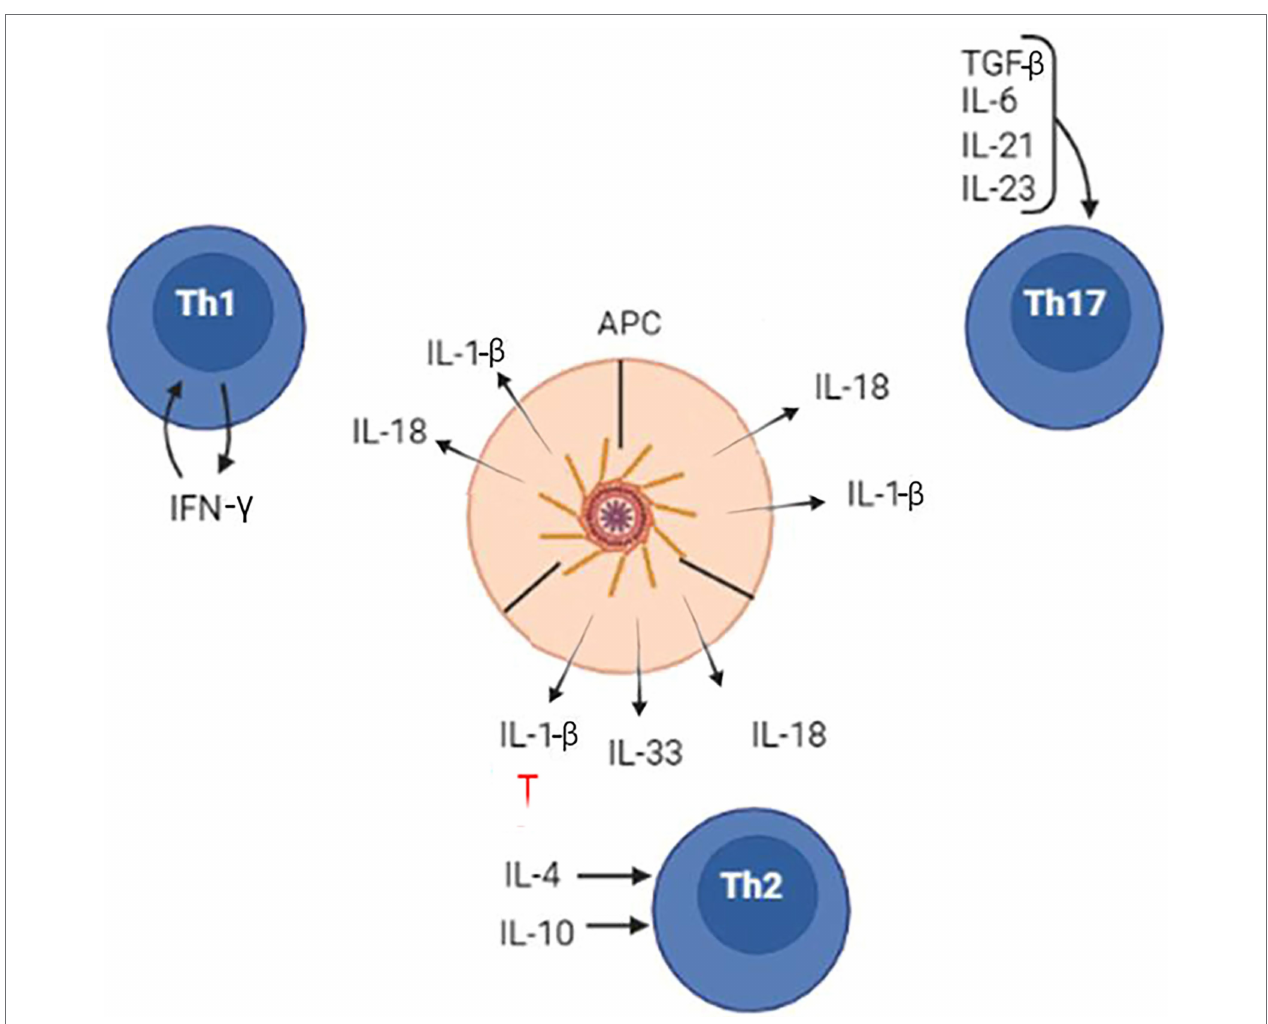
FIGURE 6 | The inflammasome role in the differentiation of naïve CD4 lymphocytes to Th1, Th2, and Th17 cells. Inflammasome products, IL-1 β , IL-18, and IL-33, contribute to differentiation of Th1, Th2, and Th17 lymphocytes. However, the lymphocyte commitments and differentiation require additional cytokines, which are released by local